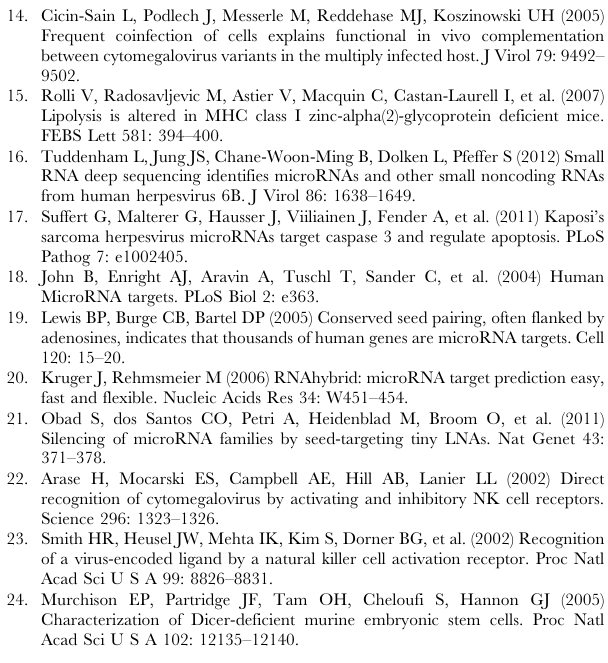
Figure S1 STAT1-dependent genes are induced in Dicer d/d mice. The difference in gene expression (fold regulation) between control and Dicer d/d splenocytes was measured; genes were separated according to the presence of STAT1-binding motifs in their promoters. ** p =0.0016. Figure S2 Dicer d/d mutation impairs IFN-stimulated genes induction upon MCMV infection of isolated macrophages. A. Scatterplot showing relative gene expression